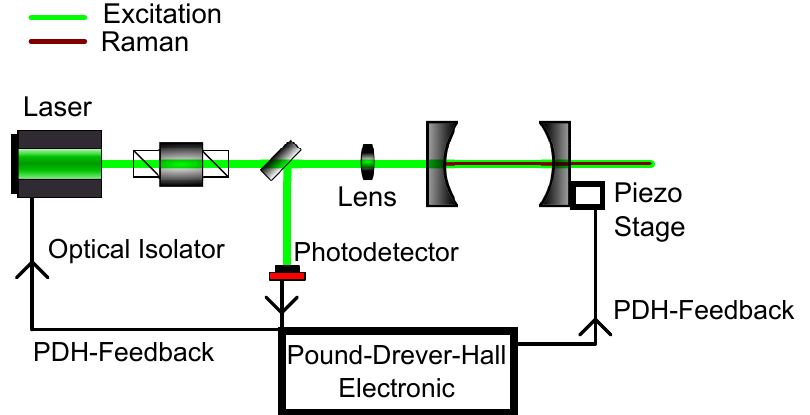
Figure 5. Schematic setup for Pound-Drever-Hall (PDH) modelocking. The reflected light of the first cavity mirror gives the necessary feedback to either change the cavity length with the use of the piezo stage or to modulate the laser frequency